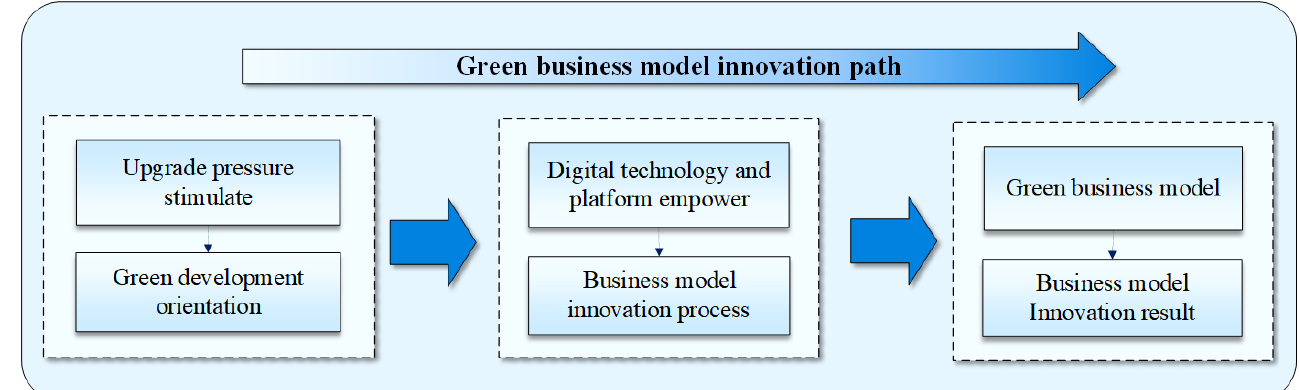
Figure 2. Research